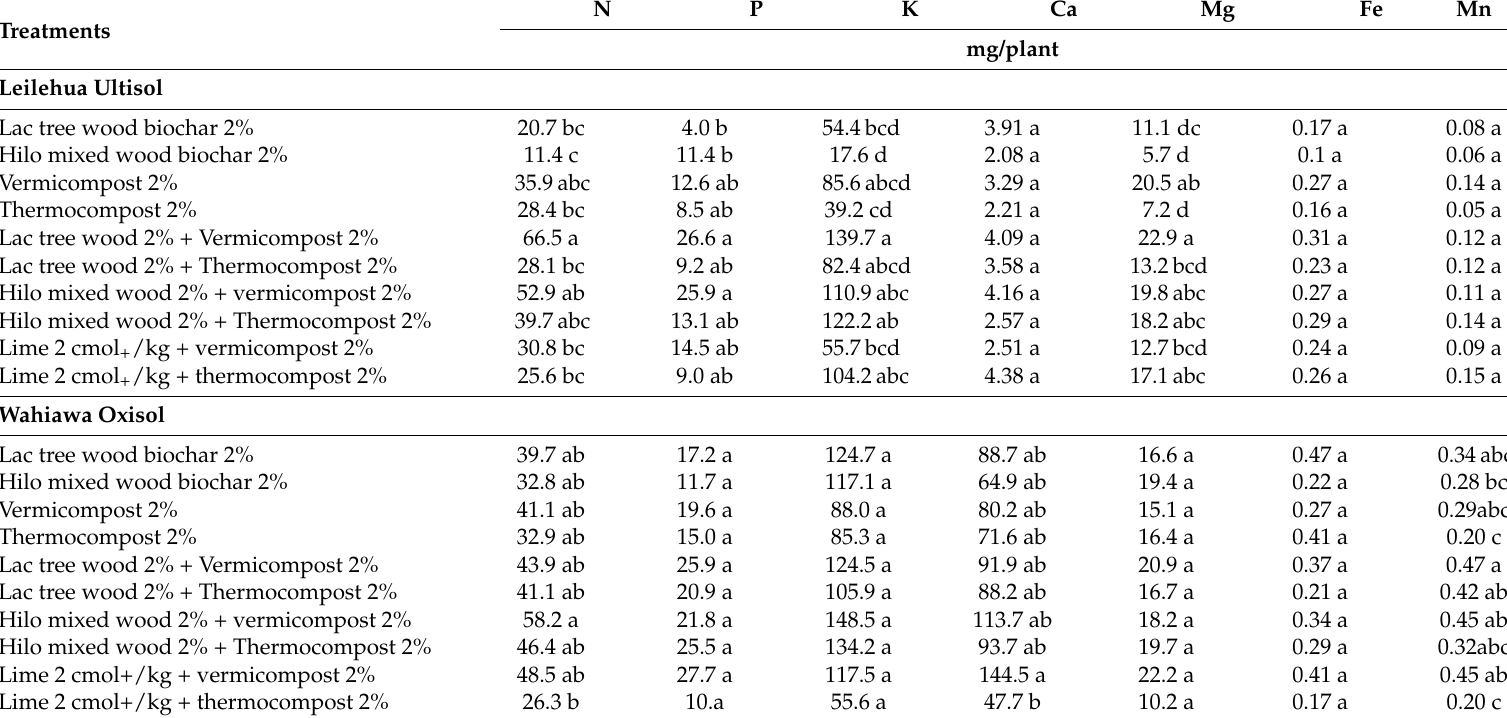
Table 7. Total nutrient uptake by Chinese cabbage in the Leilehua Ultisol as affected by biochar, lime, and/or compost additions ( n = 3). N P K Treatments